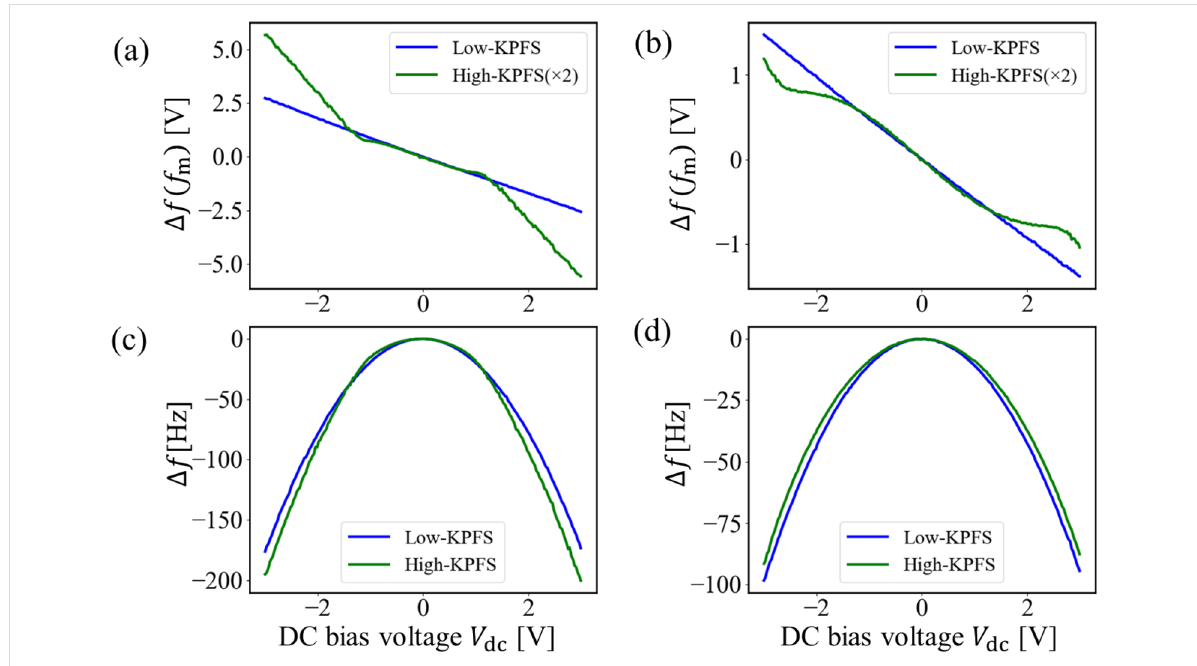
Figure 8: Δ f ( f m )– V dc curves obtained on the n-type Si surface at (a) Δ f set = − 200 Hz and (b) Δ f set = − 100 Hz. Δ f – V dc curves obtained on the n-type Si surface at (c) Δ f set = − 200 Hz and (d) Δ f set = − 100 Hz.